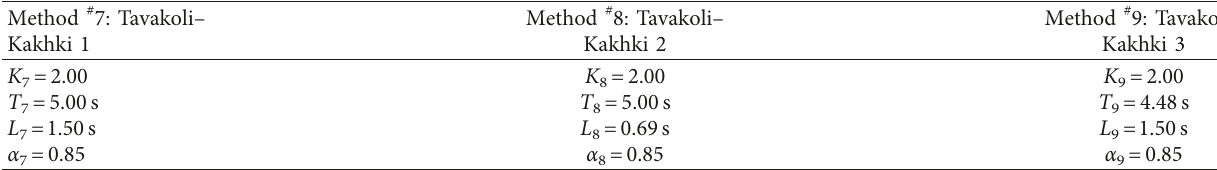
Table 22: FFOPDT model parameters for the different strategies proposed in